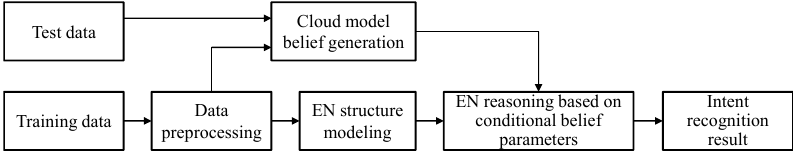
Figure 2. Process of target intention recognition in evidence network reasoning.